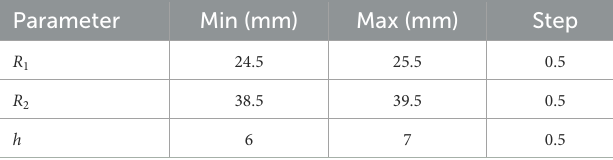
TABLE 6 Parameter ranges and steps for the third iteration of Point 1.